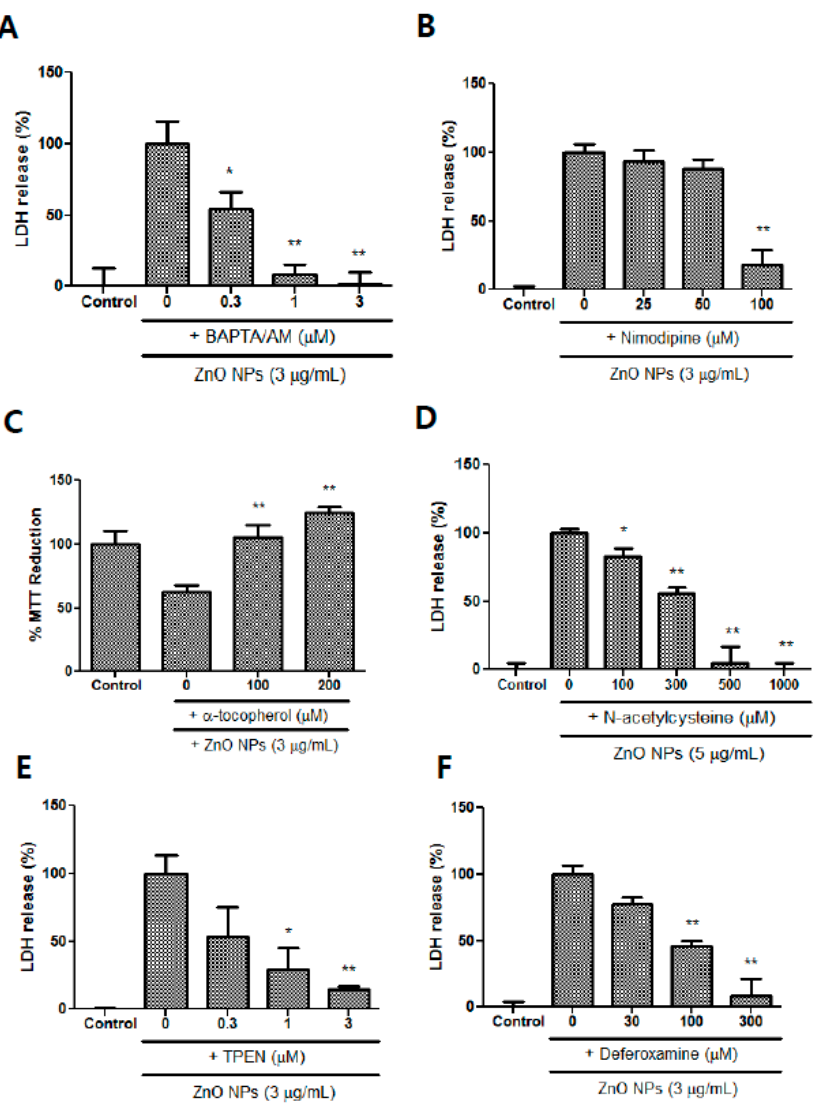
Figure 10. Protective effects of BAPTA/AM (1,2-bis(2-aminophenoxy)ethane-N,N,N ′ ,N ′ -tetraacetic acid/acetoxymethyl ester ) ( A ), nimodipine ( B ), α -tocopherol ( C ), NAC ( D ), N,N,N ′ ,N ′ -tetrakis-(2-pyridylmethyl) ethylenediamine (TPEN) ( E ), and deferoxamine ( F ) on ZnO NP-induced toxicity in astrocyte cultures. Cytotoxicity was evaluated using LDH release and MTT reduction assays. Data represents the mean ± SEM. * p < 0.05, ** p < 0.01 compared to ZnO NPs ( n = 4).